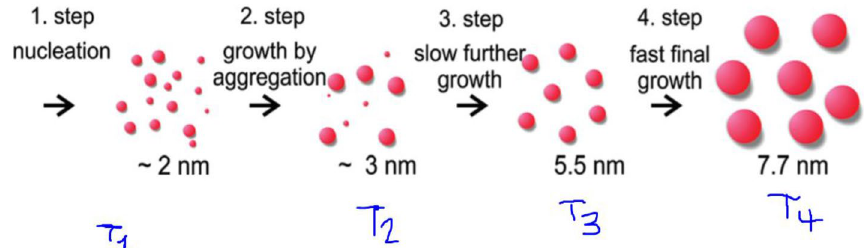
Fig. 5 Schematic illustration for effect of reaction time on the synthesis of ZnO nanoparticles (Polte et al.